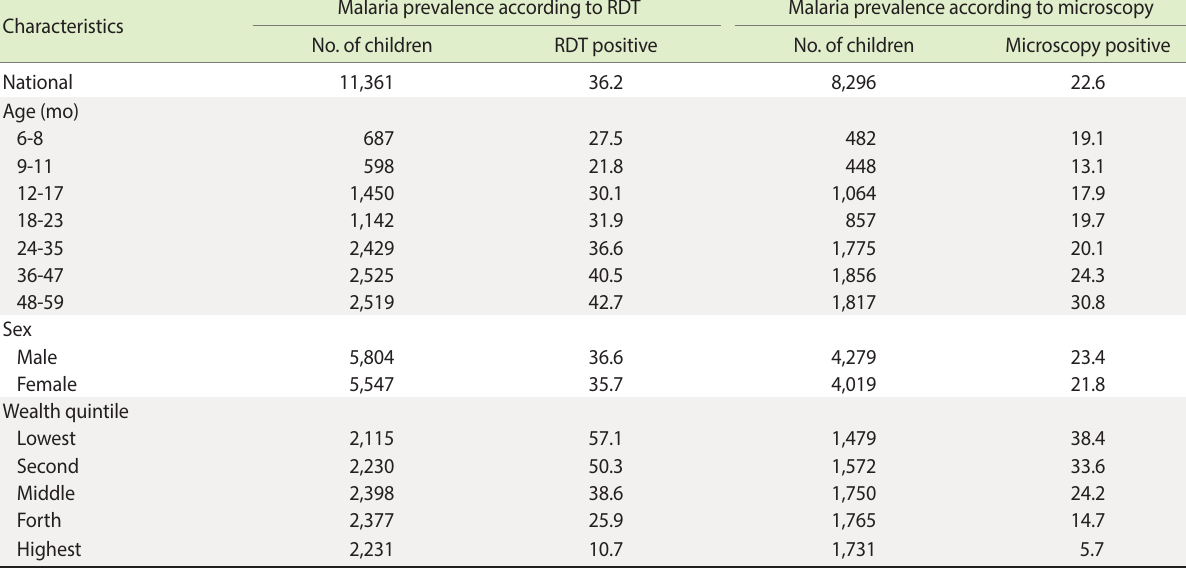
Table 1. Prevalence of malaria in children aged 6-59 months according to background characteristics Characteristics